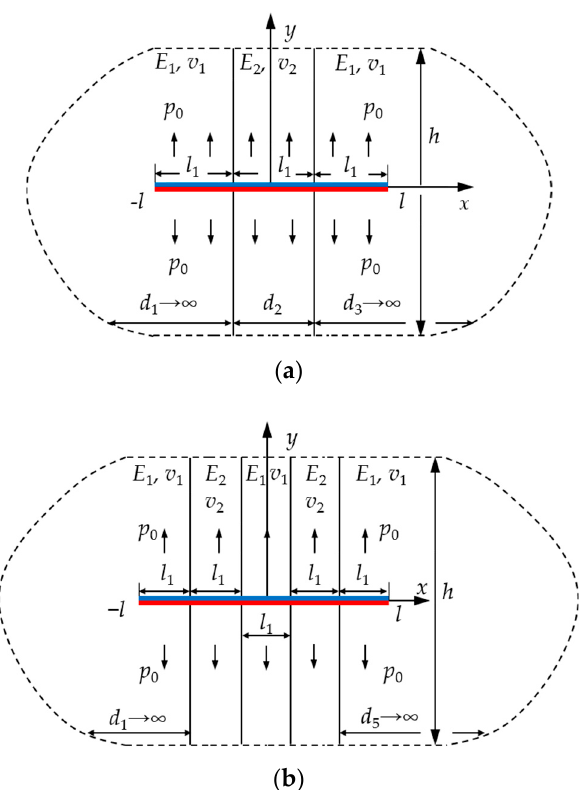
Figure 10. Schematic view of a crack intersecting a multilayered media containing ( a ) 3 layers and ( b ) 5 layers.